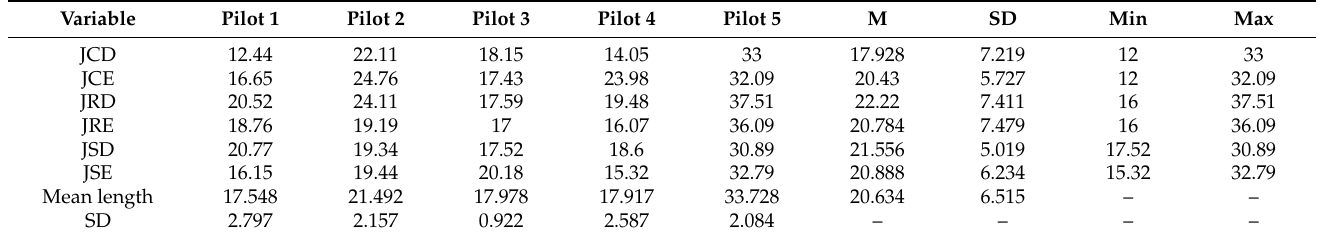
Table 2. The length of the circuit for individual pilots in flights on an airplane with a jet engine.